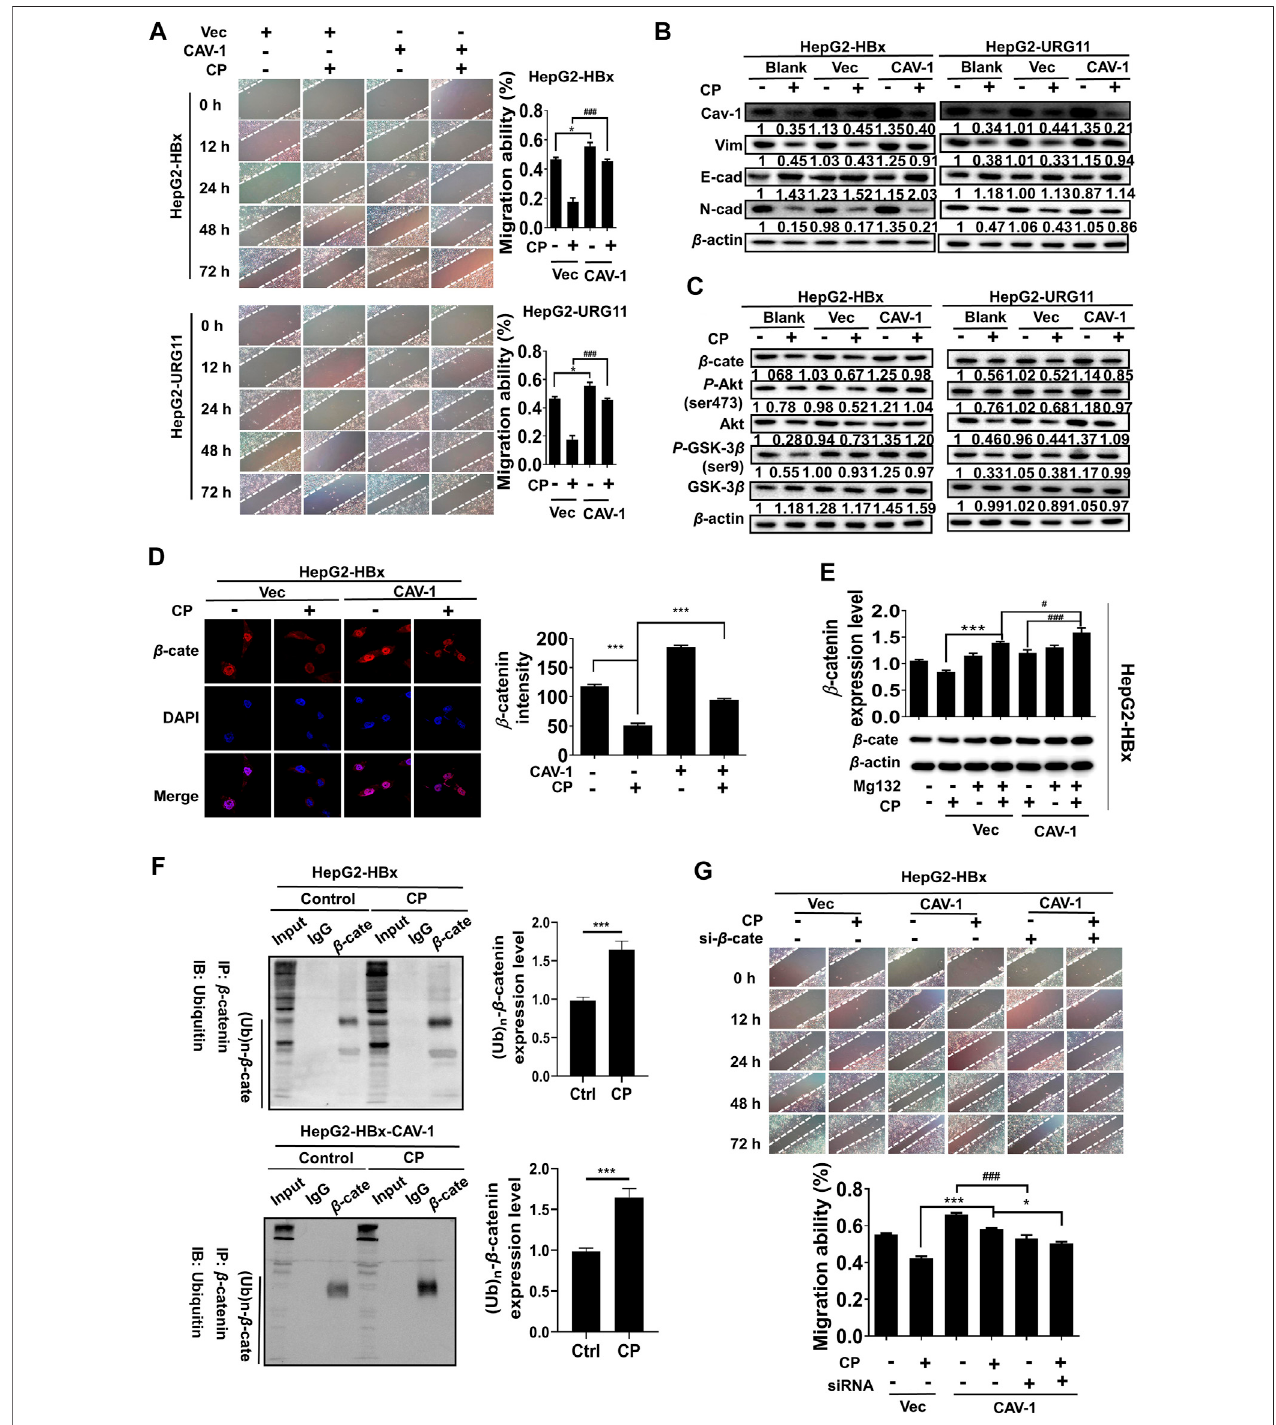
FIGURE7| Cav-1 inhibitionbyCPactivated theAkt/GSK3 β -mediatedproteasomedegradation of β -catenin via ubiquitinationactivation. (A) Wound healingassay showedthegapwidthsandareas weredecreasedintheCav-1-overexpressiongroups,whileCPtreatmentattenuated themigrationabilityofHBV-associatedcells. (B) Compared to vector control, CP attenuated the promotion effect of Cav-1 on EMT process of HBV-associated HCC. (C) Cav-1 increased β -catenin expression and activated Akt/GSK3 β pathway. CP treatment attenuated the effect of Cav-1 on β -catenin expression and Akt/GSK3 β pathway of HBV-associated HCC. (D) Immuno fl uorescence assay of β -catenin expression and distribution in the cases of high Cav-1 expression and CP treatment. (E) Compared with the vector group, accumulationof β -cateninwasacceleratedinCav-1-overexpressedgroupinthepresenceofCPfollowingMG132treatment. (F) CPsigni fi cantlyenhancedubiquitination of β -catenin inHepG2-HBx cell lines withor withoutCav-1overexpression. (G) Wound healingarrayshowedthat β -catenin knockdownpartly abrogated thecapacity of Cav-1 to promote migration in HepG2-HBx cell. All values represented the means ± SD ( n (cid:1) 3, * p < 0.05, ** p < 0.01, *** p < 0.001, # p < 0.05, ## p < 0.01, ### p < 0.001).